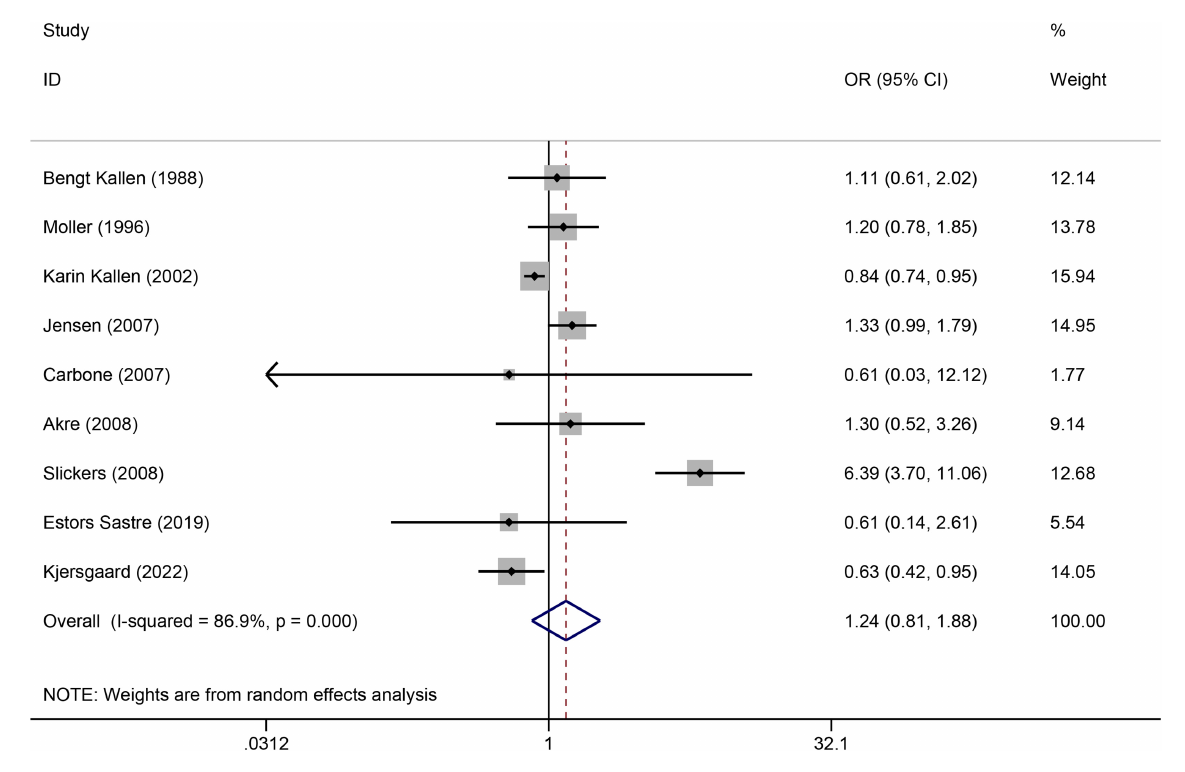
FIGURE7 Forest plot for the non-significant association of > 10 cigarettes/day when maternal smoking during pregnancy. Studies were sorted by the sequence of publication